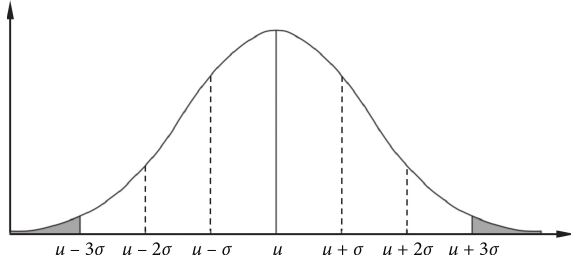
Figure 10: Normal distribution curve schematic